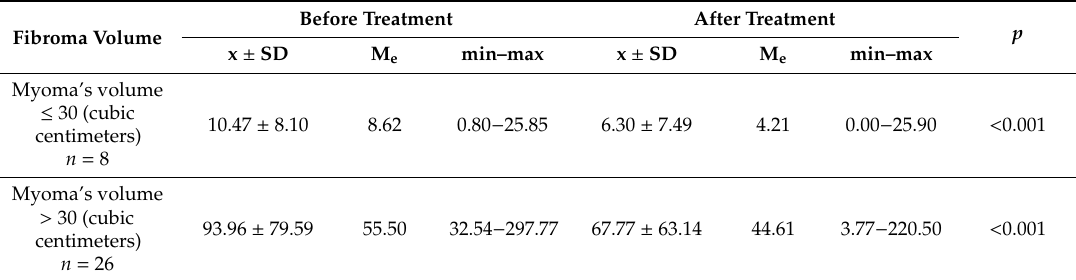
Table 2. The volume of fibroids before and after 3 months of treatment with ulipristal acetate in the group with myomas ≤ 30 cubic centimeters and the group with myomas > 30 cubic